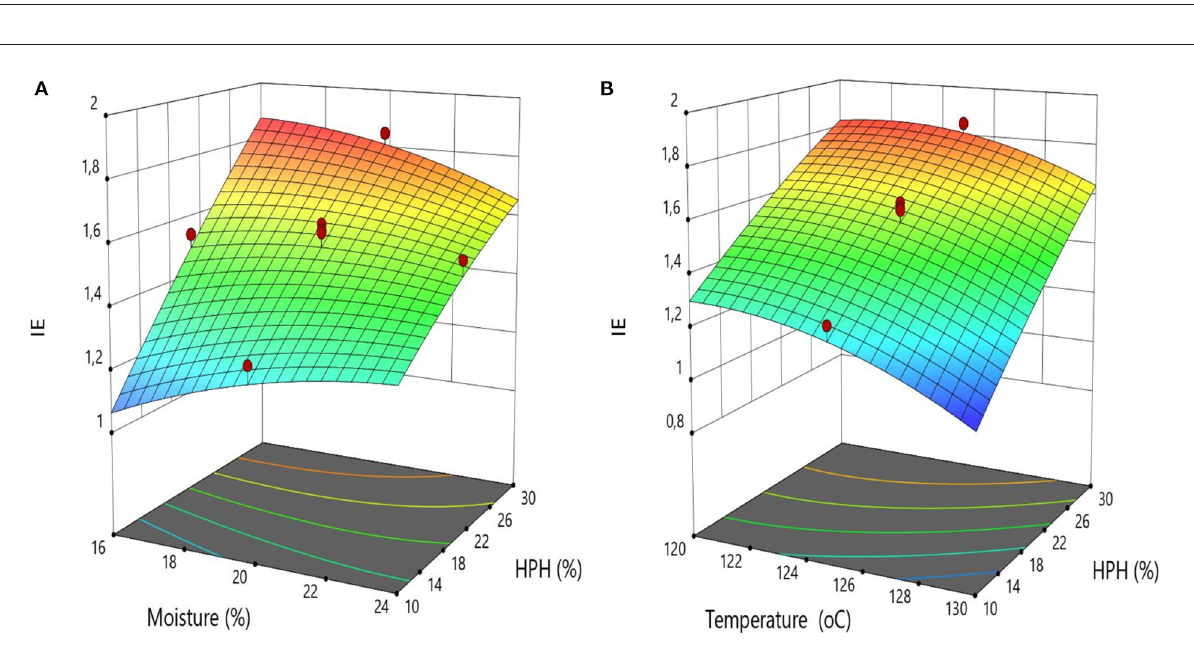
FIGURE5 Effect of HPH, moisture and temperature on hardness. (A) Moisture vs. HPH (temperature 125 ◦ C and screw speed 220 RPM). (B) HPH vs. temperature (screw speed 220 RPM and moisture